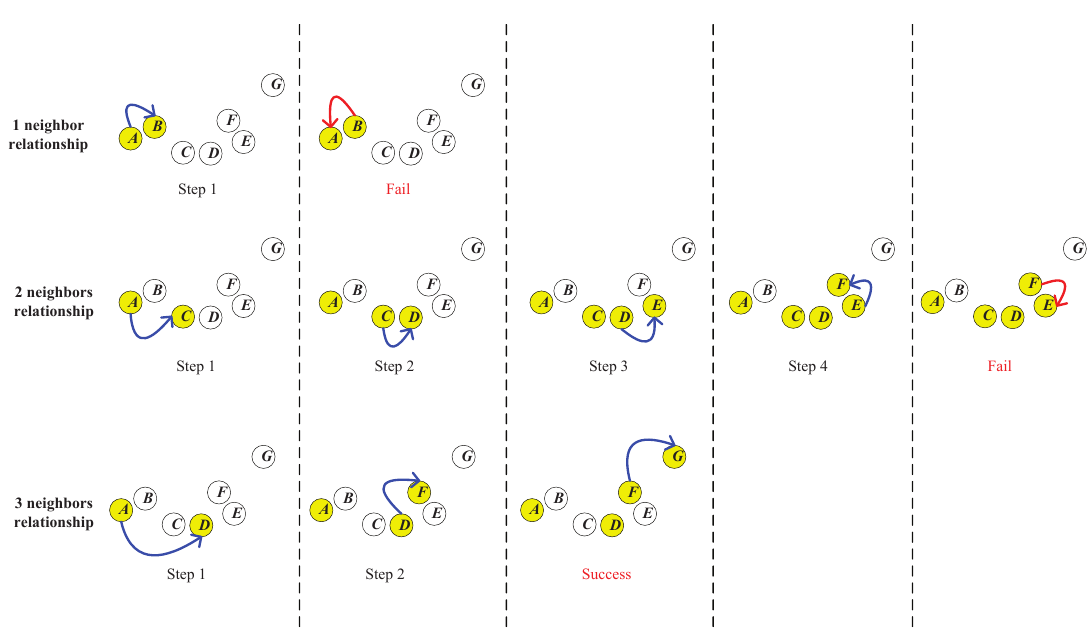
Figure 5. “Trial and error” process to determine the required neighbor’s